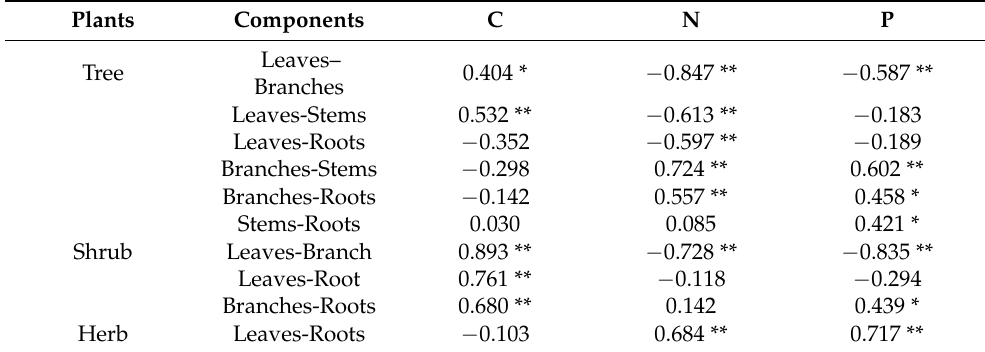
Table 3. Correlations among the C, N, and P contents and ratios in the plant, litter, and soil ( n = 27). Component C N P C:N C:P N:P TL-SL 0.613 ** TL-AH − 0.299 TL-LI TL-SO − 0.523 ** − 0.312 0.785 ** SL-AH 0.143 SL-LI SL-SO − 0.586 ** − 0.232 0.858 ** 0.05 − 0.126 − 0.263 AH-LI − 0.334 − 0.116 0.629 ** 0.074 0.377 − 0.031 AH-SO 0.193 0.771 ** − 0.15 − 0.318 − 0.368 0.572 ** LI-SO − 0.547 ** − 0.554 ** − 0.073 0.09 − 0.404 * − 0.512